Question: In a single sentence, describe what this figure presents.
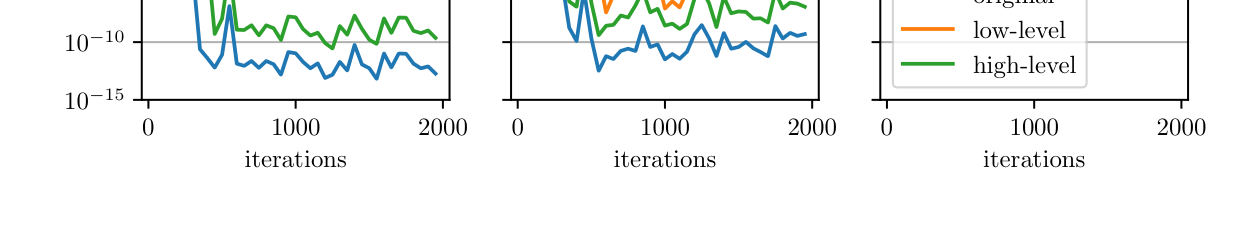
Answer: Convergence for the original solver and both differentiation strategies when applied to the BFWA398 matrix. Similar to the results in Figure 3, BICGStab and TFQMR rapidly converge and outperform GMRES. High-level differentiation performs worse than the original solver, but far better than low-level differentiation. Once again, TFQMR appears to be better suited for low-level differentiation and leads to reasonable results for both differentiation approaches.